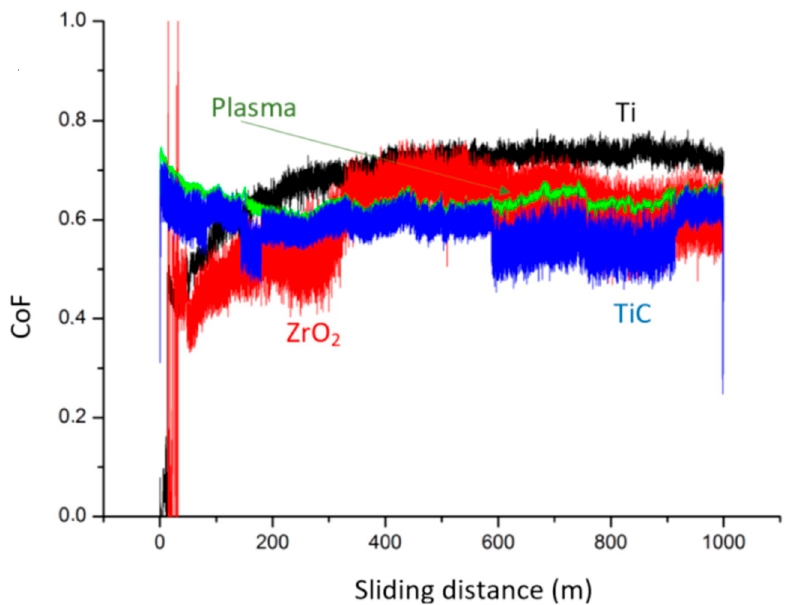
Figure 11. CoF as a function of the dry sliding distance against alumina ball at 450 °C.